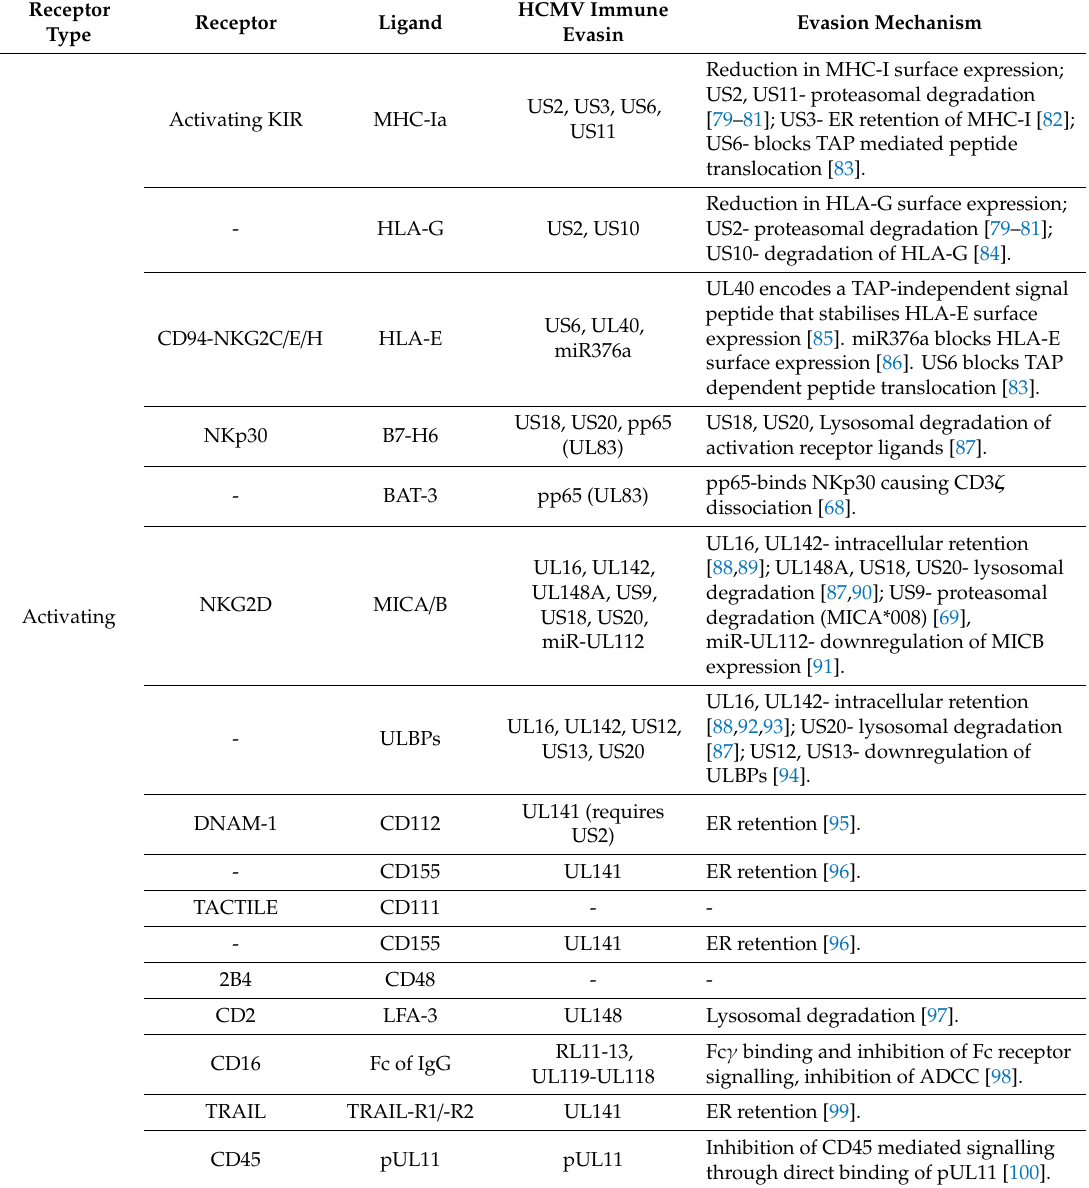
Table 1. Mechanisms by which HCMV evades NK